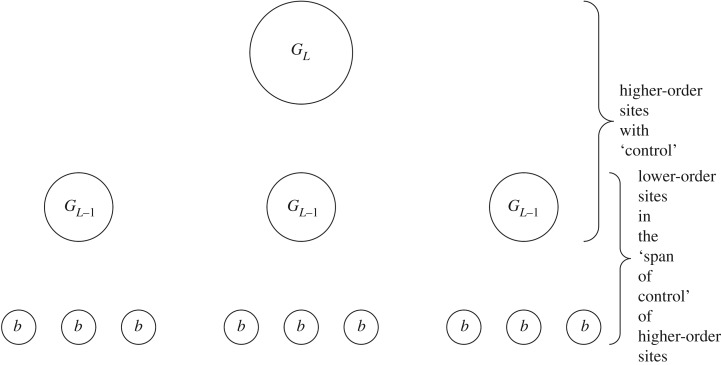
Span of control. In this illustration, s=3, l=3 and b≥1. N(GB)= 9, N(GB+1)=3, N(GB+2)=1. s=(N(GB+0)+N(GB+1))/(N(GB+1)+N(GB+2))= (9+3)/(3+1)=3.